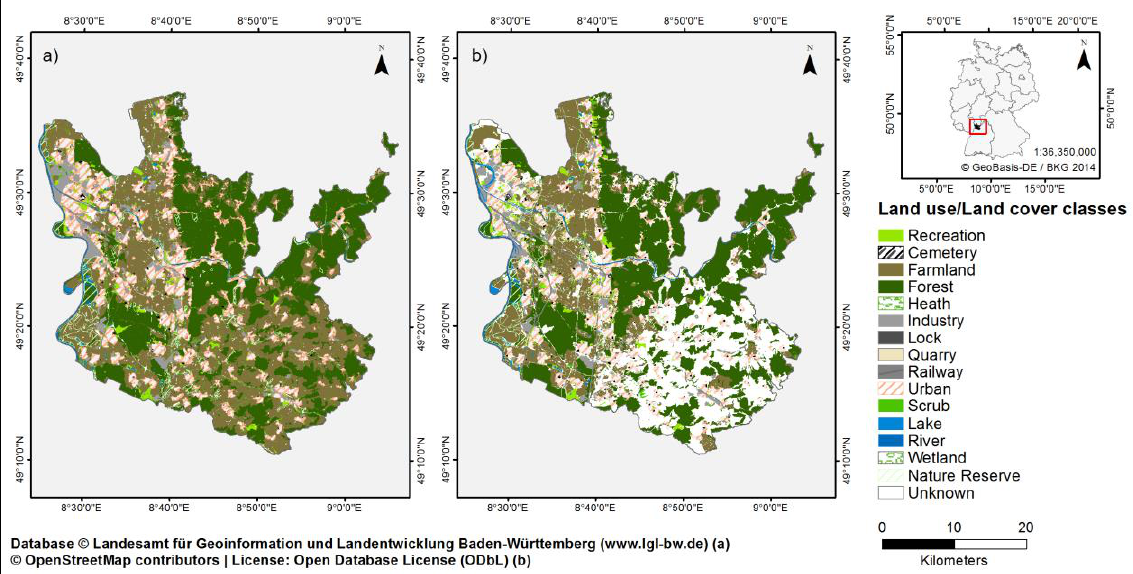
Figure 1. Land use/Land cover of the study area (Rhine-Neckar region) from ( a ) ATKIS Base DLM, and ( b )